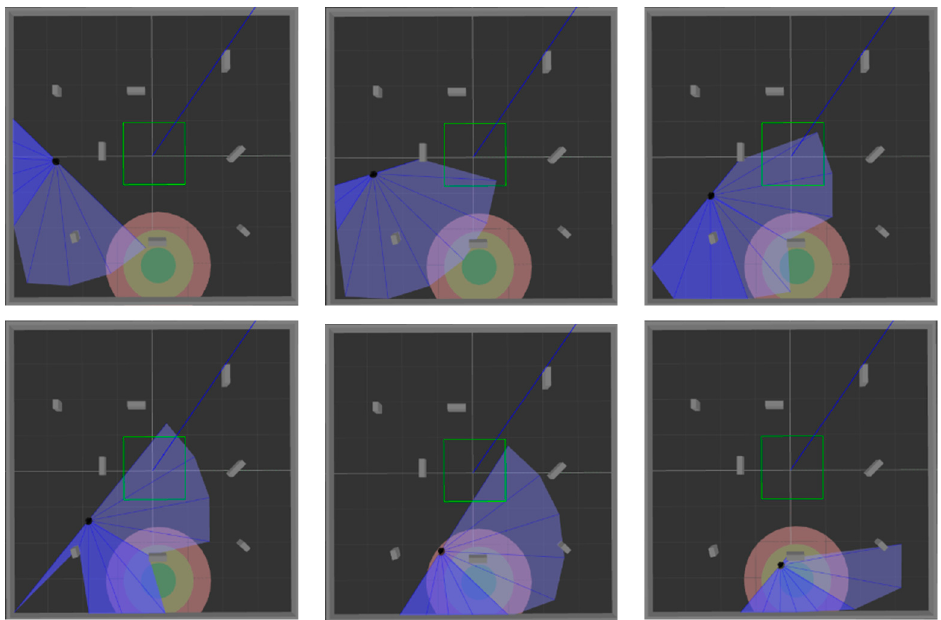
Figure 9. The movement process of mobile robot in simulation Figure 6a.